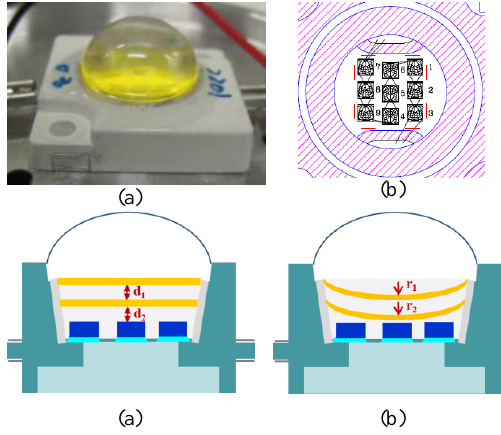
Figure 1 : Photograph of WLEDs structure: (a) Actual Fig. 1: Photograph of WLEDs structure: (a) Actual WLEDs, (b) Bonding diagram, (c) Illustration of FDRP, WLEDs, (b) Bonding diagram, (c) Illustration (d) Illustration of CDRP of FDRP, (d) Illustration of